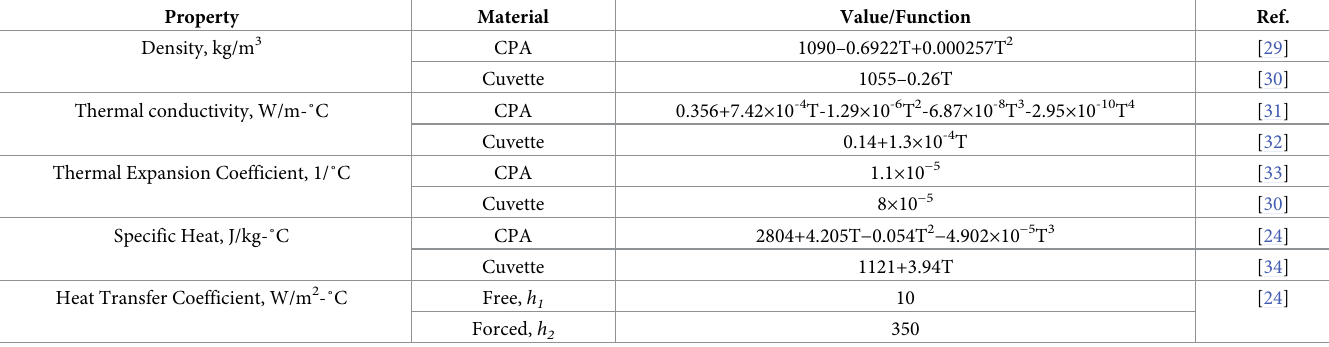
Table 1. Material properties of 7.05M DMSO and polystyrene used in this study (temperatures are in ˚C).